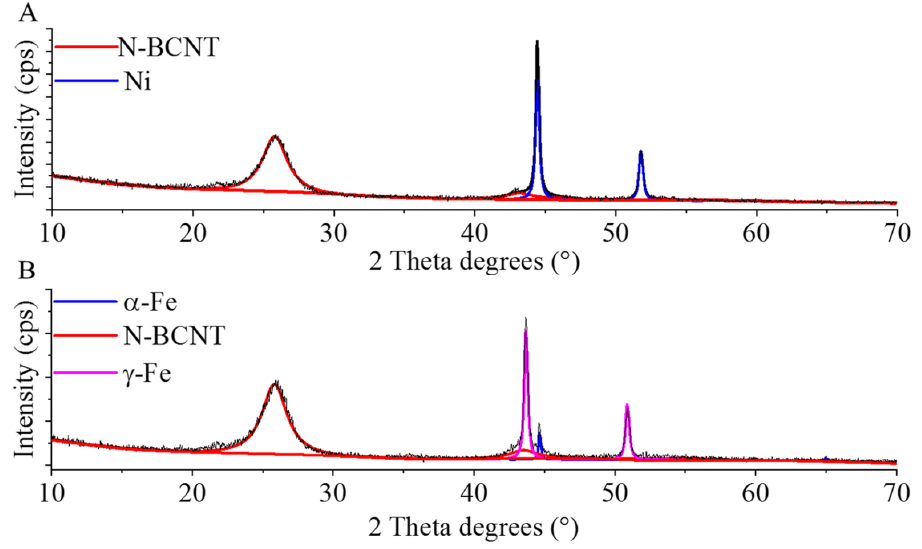
Figure 2. SEM images of the nickel ( A ) and magnetite ( B ) containing N-BCNT loaded gel beads. To determine the composition of the nickel and iron-containing beads, XRD measure- ments were carried. On the diffractogram of the Ni-GCNC, peaks were identified at 44.4 ◦ and 51.8 ◦ two theta degrees, which can be associated with (111) and (200) reflexions (PDF 04-0850), and characteristic to the metallic nickel phase (Figure 3A). The reflexions at 25.8 ◦ (002) and 43.1 ◦ (100) indicate the presence of a carbon phase as well (PDF 75-1621). In the case of the Fe-GCNC sample, the (111) and (200) reflexions at 43.7 ◦ and 50.9 ◦ 2 θ degrees (PDF 06-0696) belong to the α -Fe phase (Figure 3B). Furthermore, the reflexion at 44.6 ◦ (110) confirmed that the carbonization of the gel beads led to the formation of a γ -Fe phase. The presence of elemental metallic particles can be explained by the reducing effect of carbon at high temperatures (800 ◦ C).